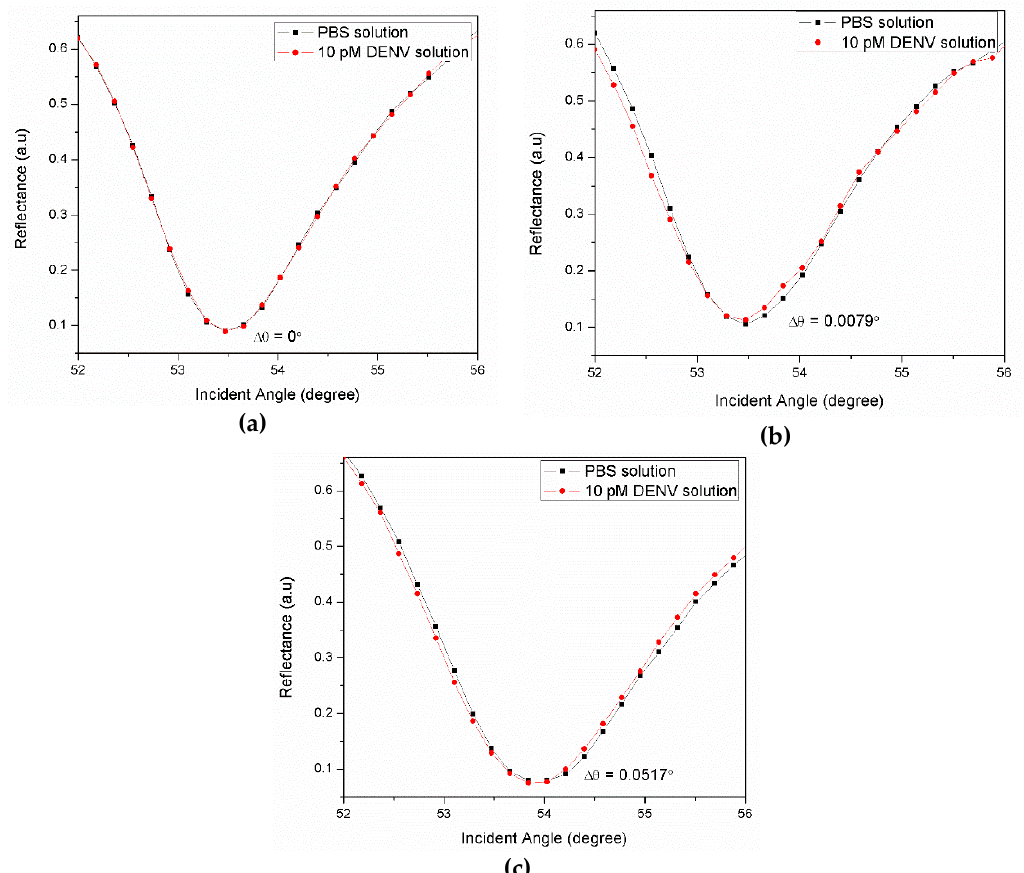
Figure 4. Optical reflectance for 10 pM dengue virus (DENV) solution in contact with ( a ) Au, ( b ) Au/Ab, and ( c ) Au/CdSQDs-rGO/Ab sensor film.